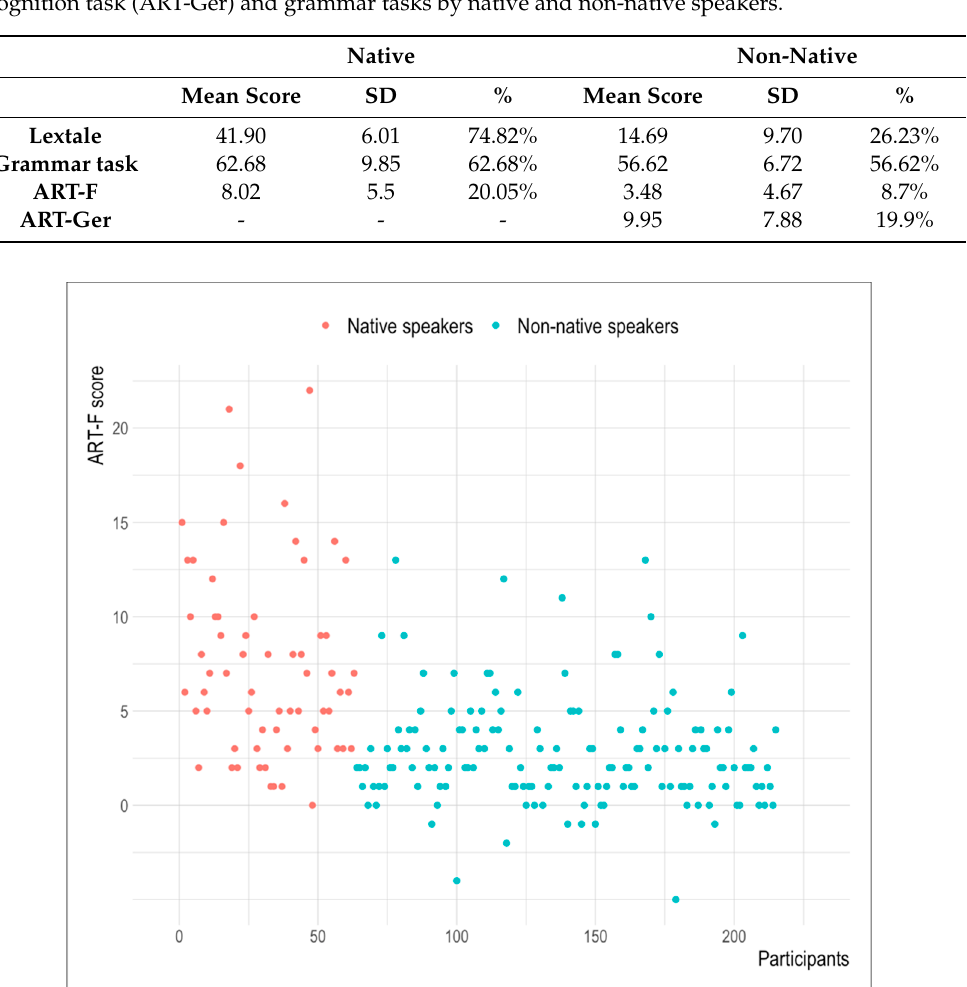
Figure 2. Score of the grammar task per participants.